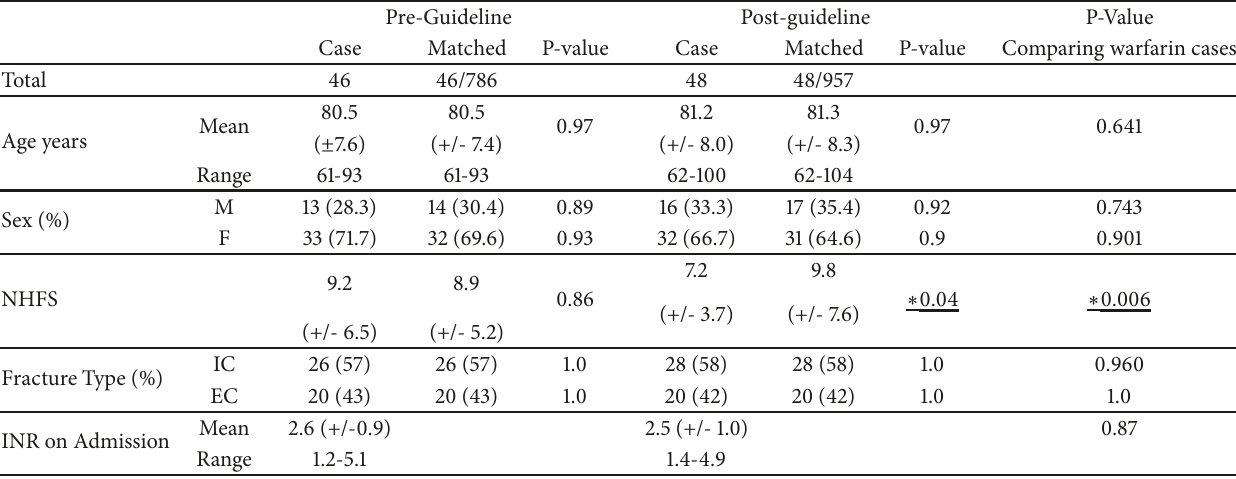
Table 1: Summary of study population demographics for propensity score matched cohorts pre- and post-guidelines. (M: male, F: female, IC: intracapsular, EC: extracapsular; comparing warfarin cases column relates to the warfarin cases pre- and post-guideline; ∗ p < 0.05 is statistically significant.)